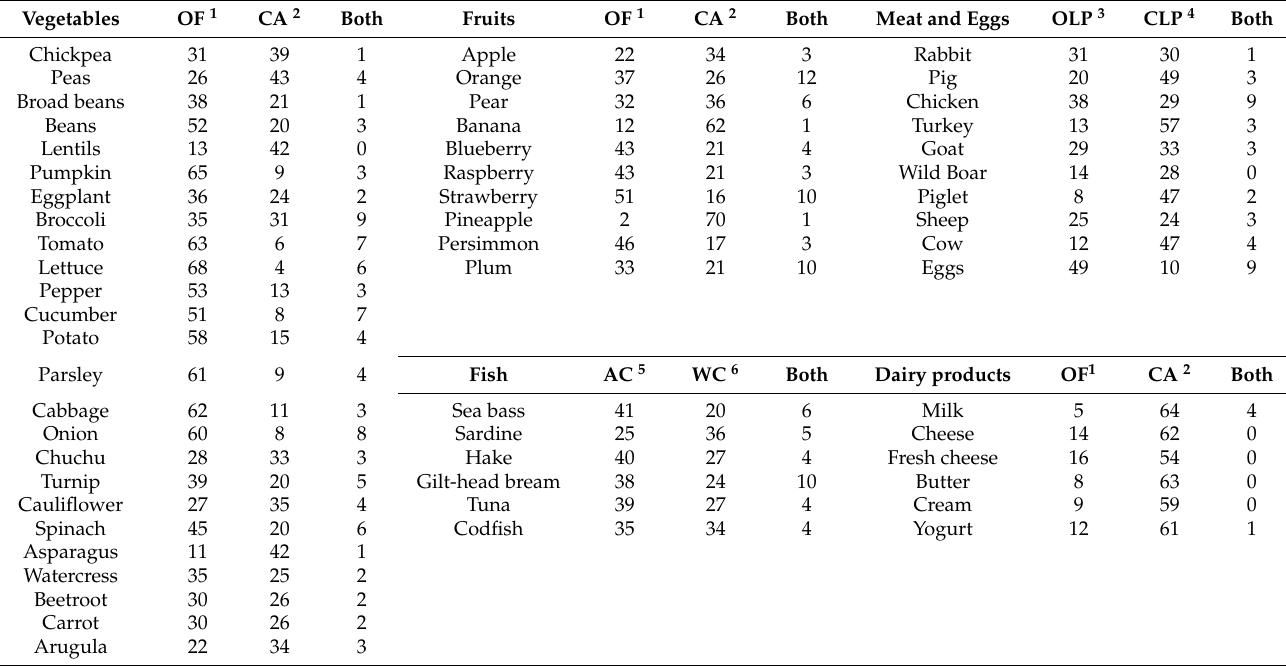
Table 1. Consumption of food products according to the agricultural production system—represented as percentage (%) of positive